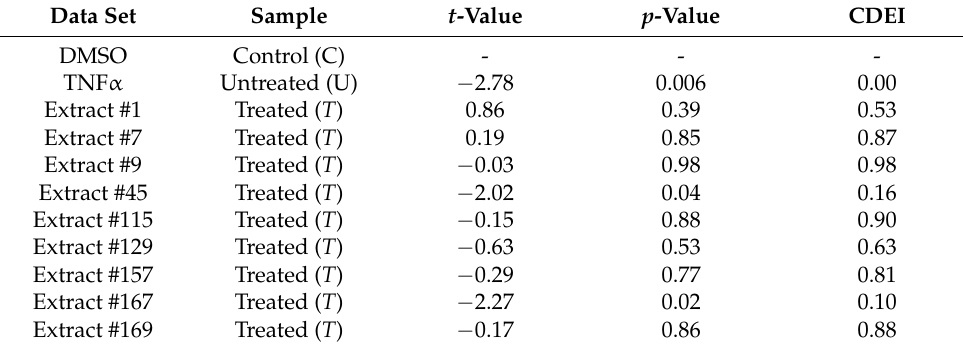
Table 4. CDEI testing results—EpiOral.